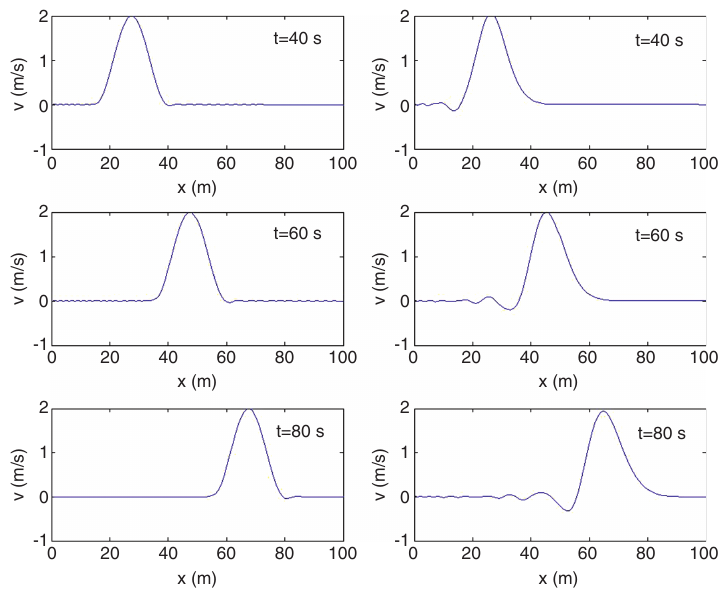
Figure 1 Wave propagation along bar for ℓ = 0 m (left) and ℓ = 1 m